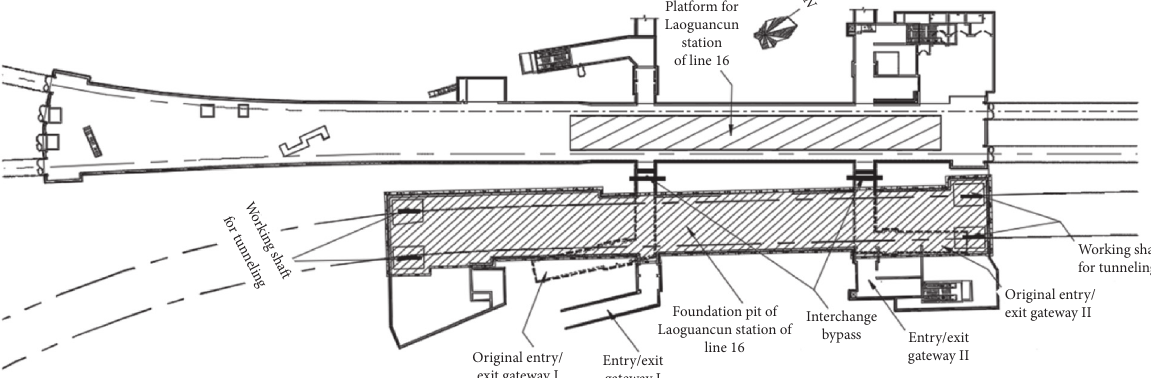
Figure 1: Schematic project